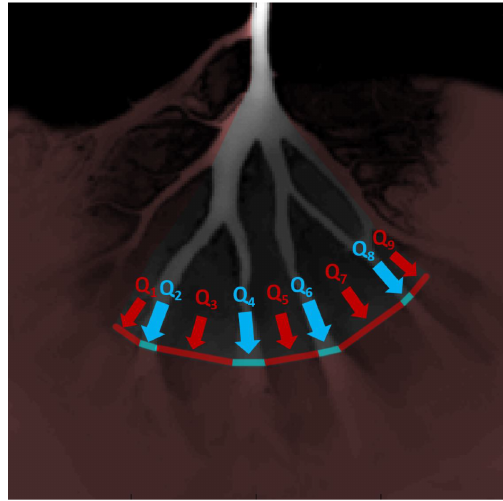
Figure 14. Setup used for analyzing the effect of the parameter γ on modeling results. The ratio of the discharge coming out of four main channels ( Q 2 , Q 4 , Q 6 , Q 8 ) and the discharge coming out of the downstream side of the islands ( Q 1 , Q 3 , Q 5 , Q 7 , Q 9 ) is measured to quantify how much flow is routed through the island as a function of the parameter γ